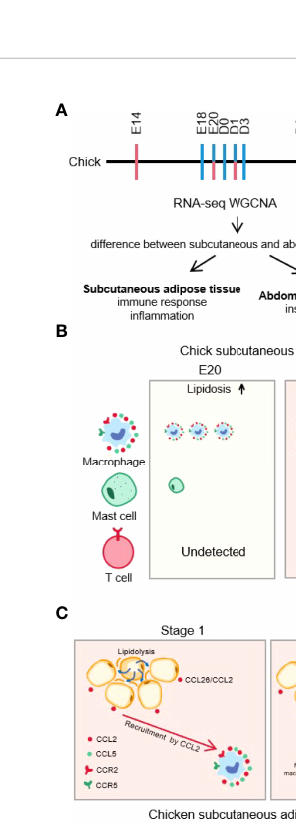
FIGURE 14 | FFA-induced macrophage foaming. (A) FFA-induced RAW264.7 macrophage foaming (Oil red and Nile red staining); (B) quantization of FFA-induced RAW264.7 macrophage foaming (Oil red staining); (C) FFA-induced chicken macrophage foaming (Oil red and Nile red staining); (D) quantization of FFA-induced chicken macrophage foaming (Oil red staining). a,b= p <0.05.